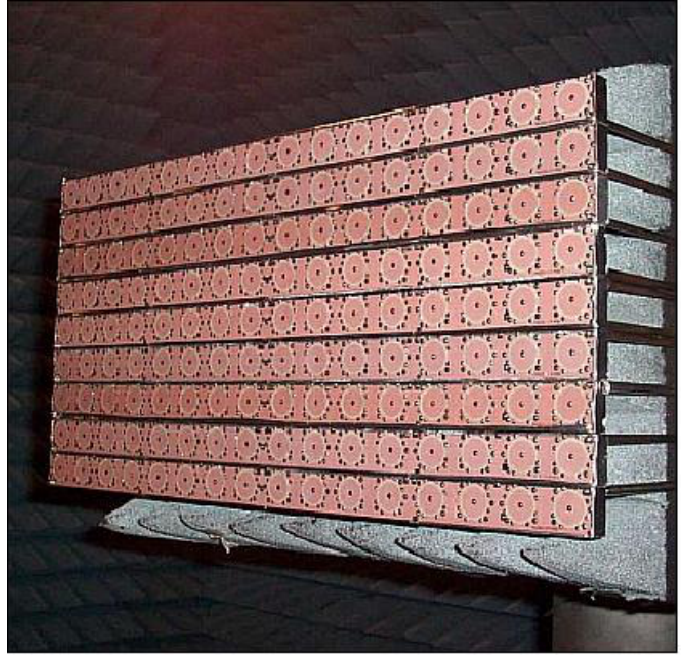
Figure 13. PAZ panel subarrays